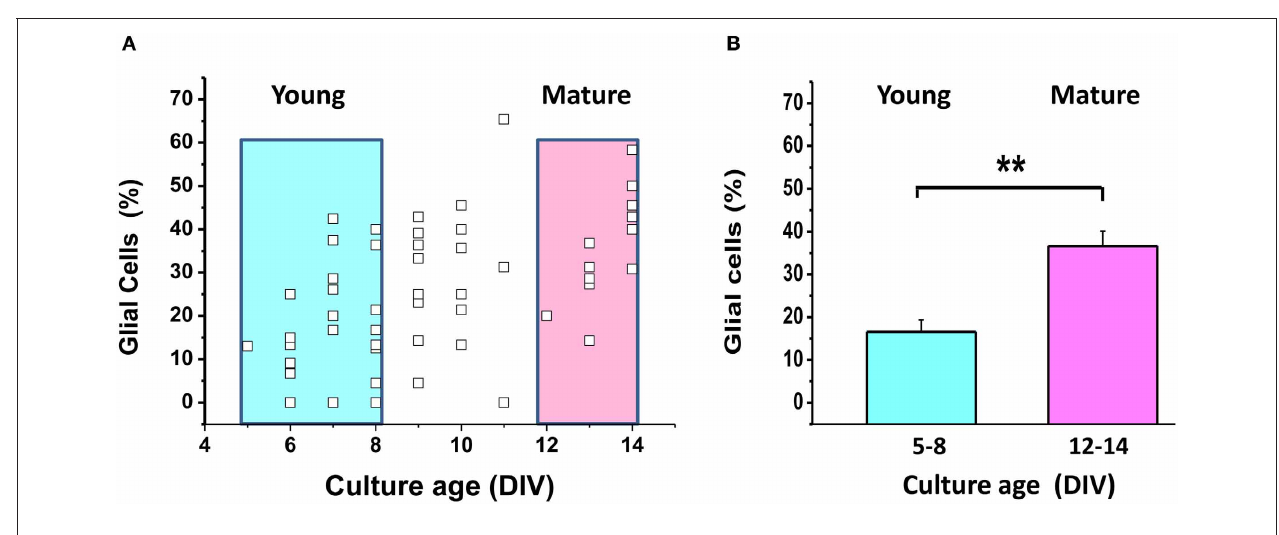
FIGURE A2 | The proportion of glial cells increases during maturation of mixed neuro-glial cultures. (A) The small empty squares depict the proportion of glial cells (as % of all cells) in each of 57 fields of observation. Color boxes outline young (5–8 DIV) and mature (13–14DIV) cultures. (B) Mean proportionof glial cells in young and mature cultures highlighted by color boxes in (A) . Identification